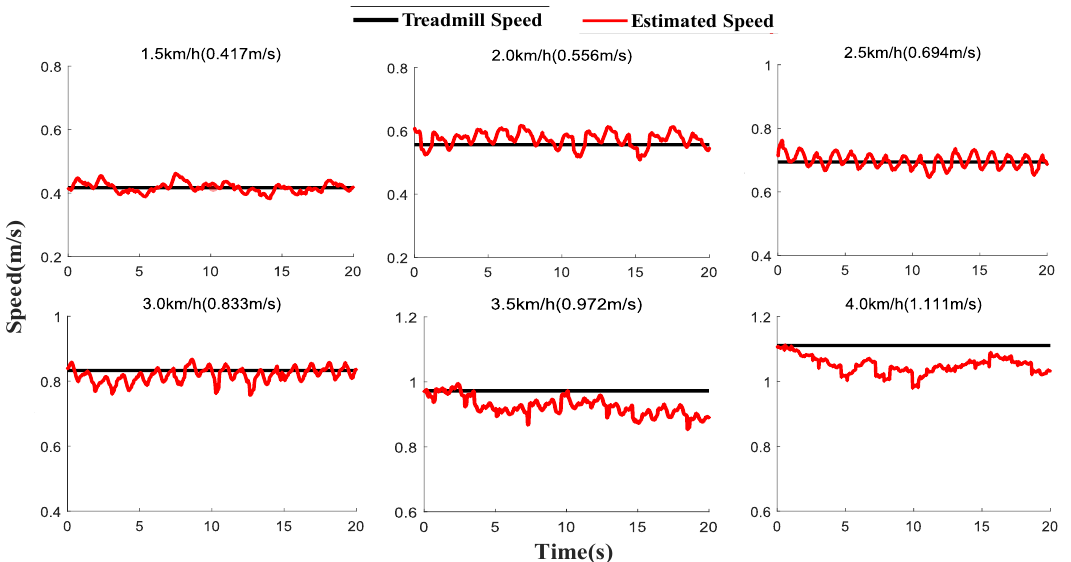
Figure 8. Experimental results based on the PW dataset.